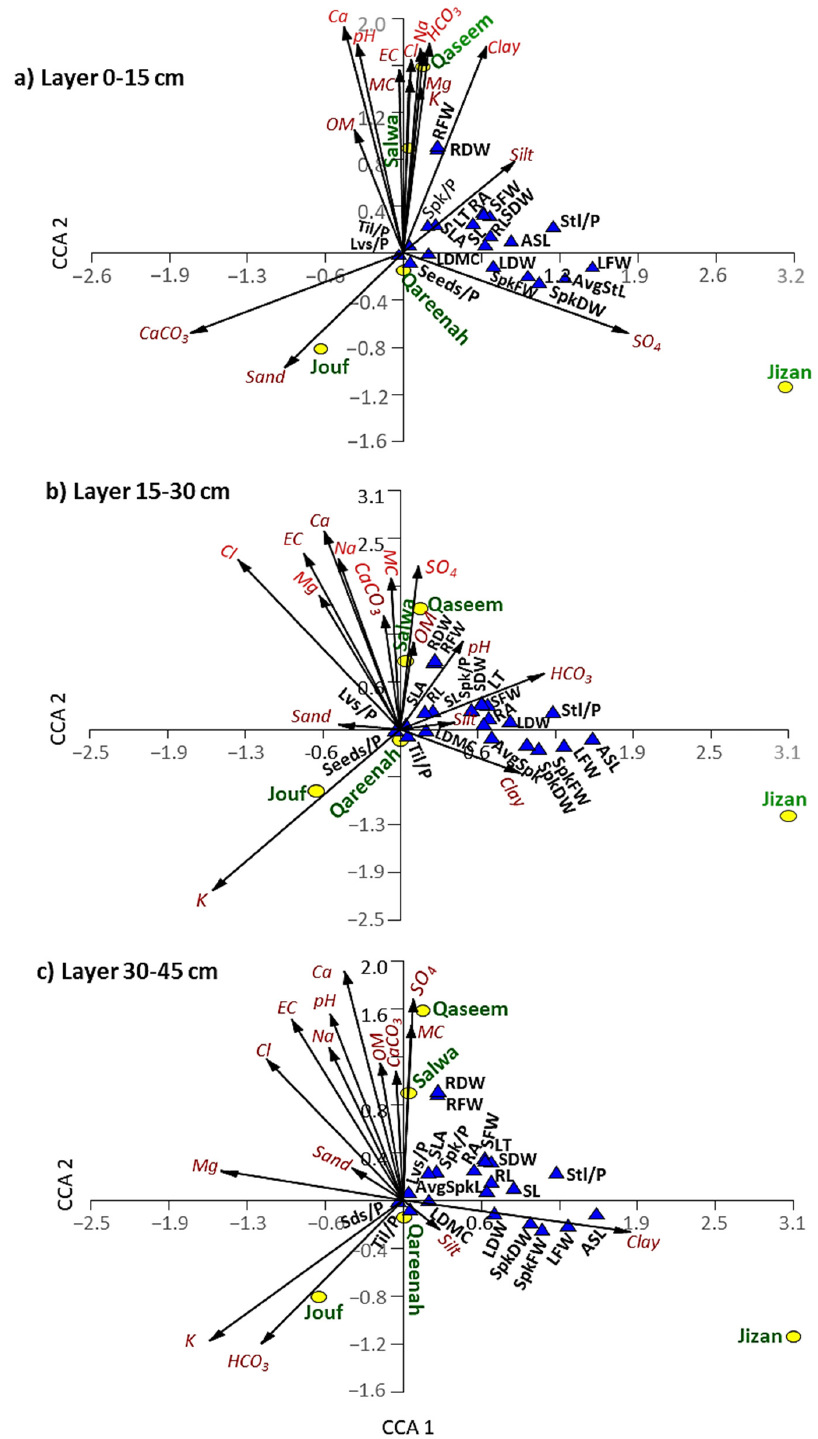
Figure 9. Canonical correspondence analysis (CCA) showing the correlations among the soil variables of different layers separately (( a ): 0–15 cm, ( b ): 15–30 cm, and ( c ): 30–45 cm layers), regions, and morphological traits of A. lagopoides . SFW: shoot fresh weight, SDW: shoot dry weight, RFW: root fresh weight, RDW: root dry weight, lvs/ p ; number of leaves per plant, SLA: specific leaf area, Spk/ p : number of spikes per plant, AvgSpkL: average spike length, RA: root area, LT: leaf thickness, SL: shoot length, RL: root length, Stl/ p : number of stolon per plant, LDMC: leaf dry matter content, LFW: leaf fresh weight, LDW: leaf dry weight, SpkFW: spike fresh weight, SpkDW: spike dry weight, ASL: average stolon